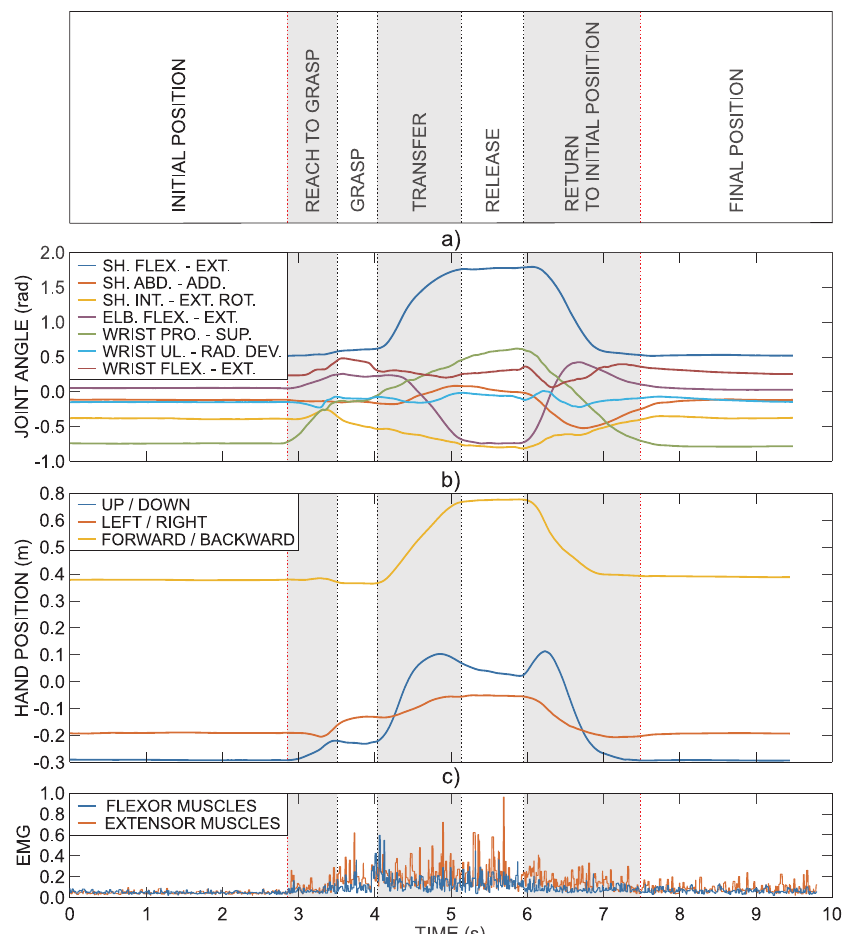
Figure 2. Hand and arm joint trajectories with the corresponding EMG activity. Hand and arm joint trajectories for the task that requires reaching for a block, transferring it onto the shelf and returning the hand to the initial position: ( a ) arm joint angles; ( b ) hand position relative to the trunk coordinate frame; and ( c ) normalized EMG activity of fingers and wrist flexor and extensor